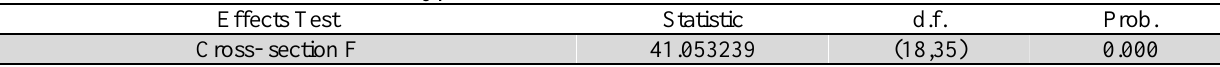
Redundant Fixed Effects Tests of Hypothesis